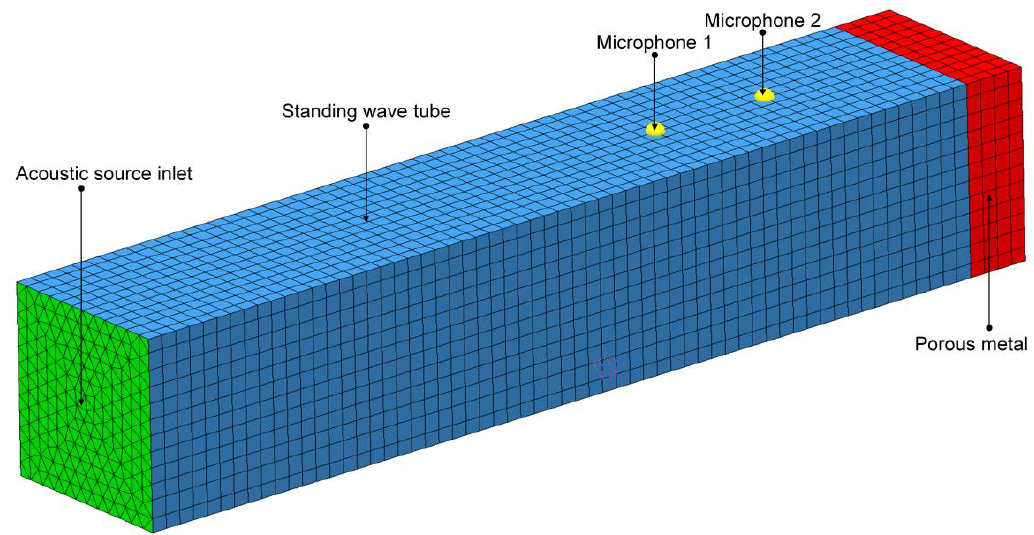
Figure 3. The constructed finite element simulation model for the original porous metal and the uniform compressed porous metal.